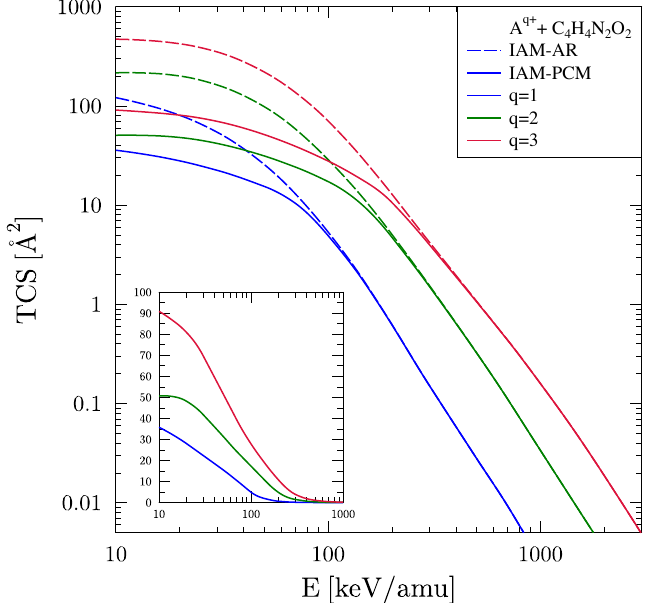
Figure 8. Net electron capture cross section for collisions of protons, He 2 + , and Li 3 + ions with uracil (C 4 H 4 N 2 O 2 ). The dashed curves show the IAM-AR results, while the solid curves are obtained with the IAM-PCM. The curves merge at lower energies for proton impact (shown in blue), followed by He 2 + impact (shown in green), and even higher energies for Li 3 + projectiles (shown in